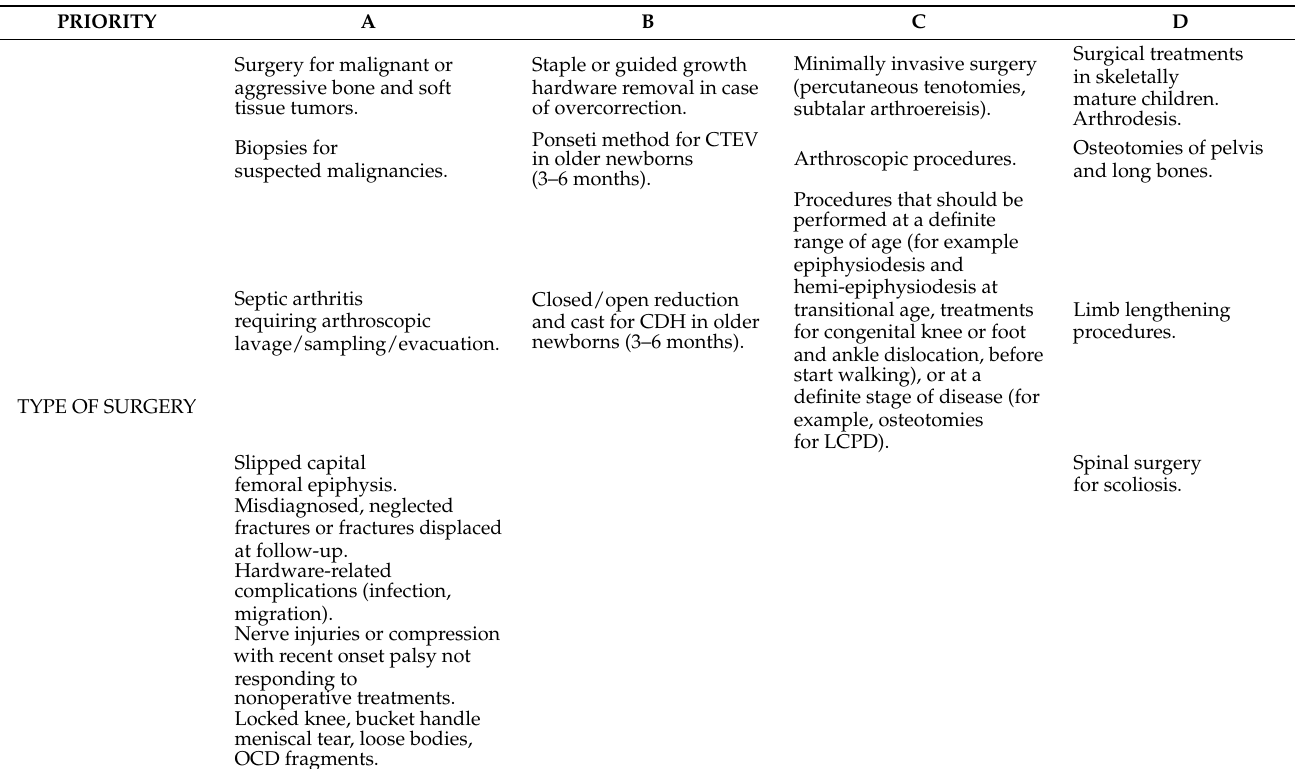
Table 1. Priority class for elective pediatric orthopedic surgery [7]. OCD: osteochondral disease. CTEV: congenital talipes equinovarus. CDH: congenital dislocation of the hip. LCPD: Legg–Calve–Perthes Disease.